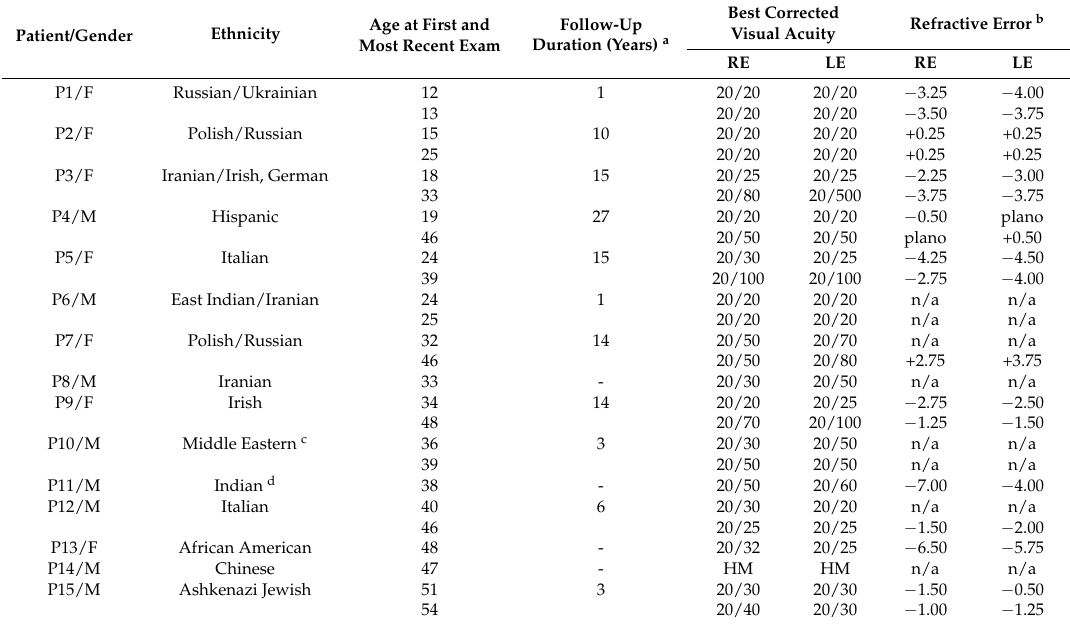
Table 2. Clinical Characteristics of EYS -RP